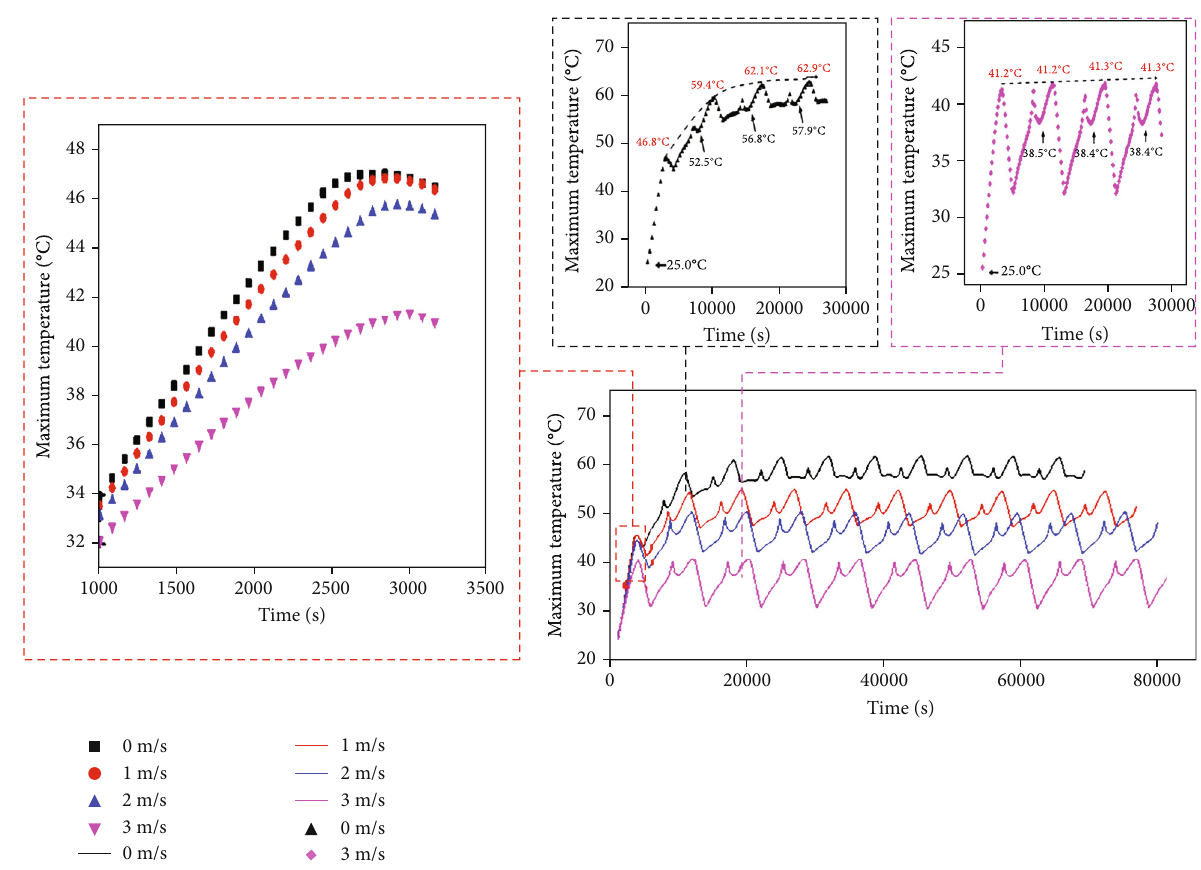
Figure 6: Temperature variations of the FC module with di ff erent forced air fl ow rates during the cycle process (1